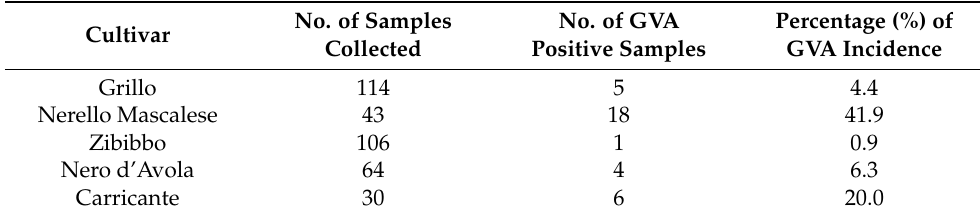
Table 2. Number of samples collected and incidence percentage for each cultivar tested by DAS-ELISA and end-point RT-PCR for Grapevine virus A.